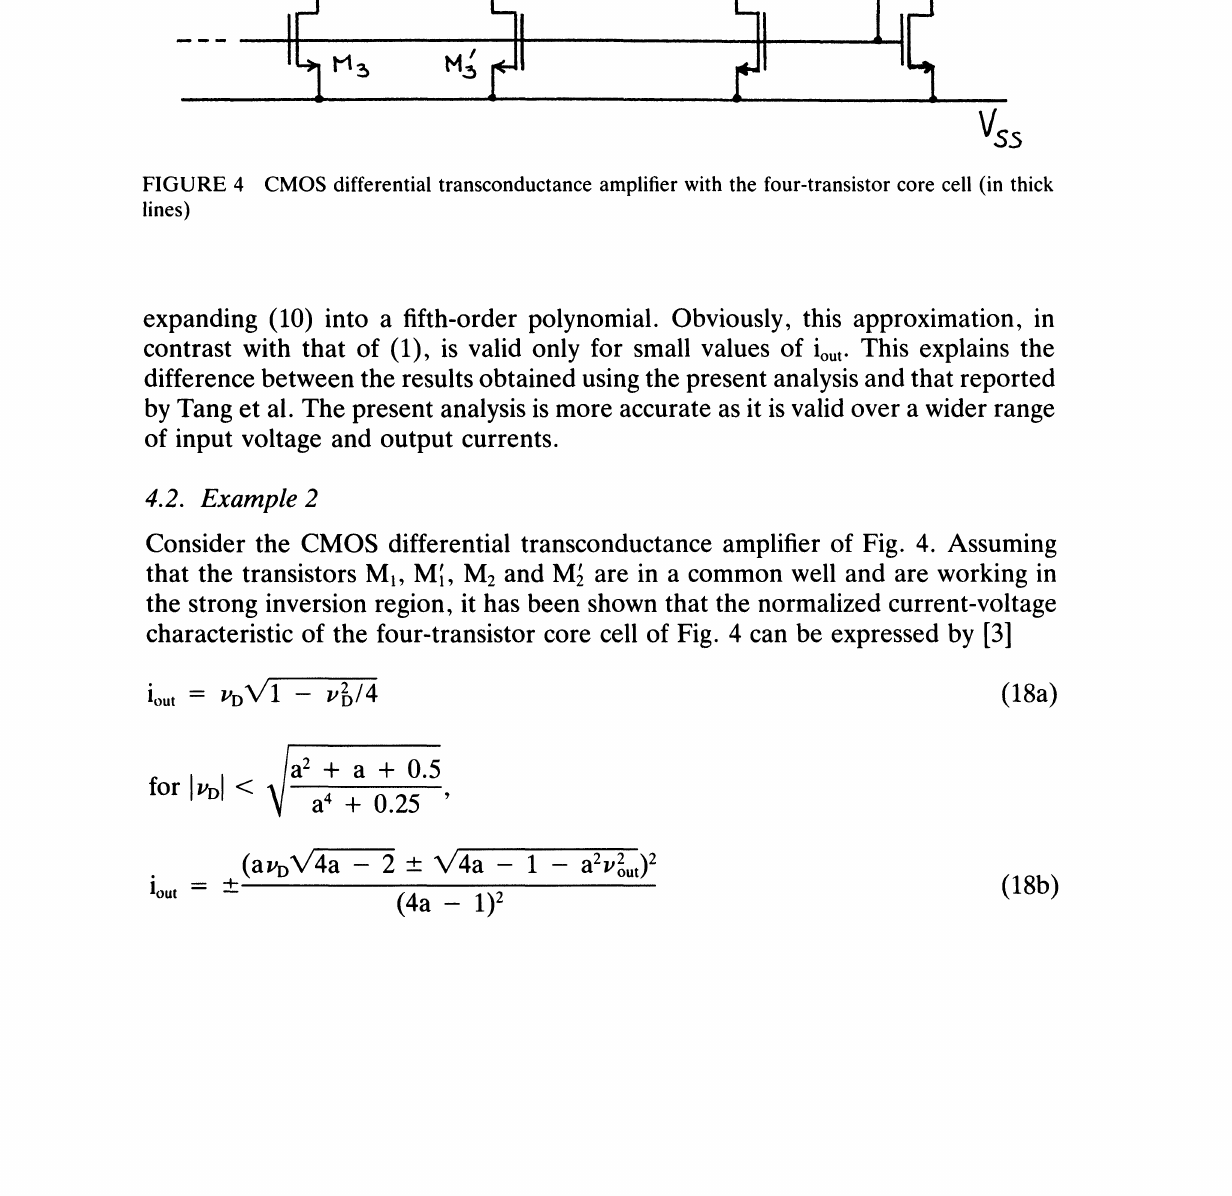
expanding (10) into a fifth-order polynomial. Obviously, this approximation, in contrast with that of (1), is valid only for small values of iout. This explains the